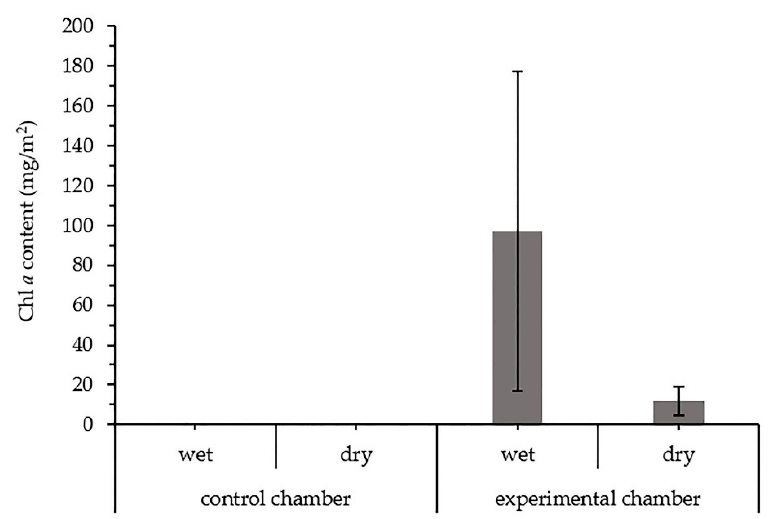
Figure 10. Chlorophyll a content in the biocrusts (mg/m 2 ). The pigment was analyzed in a wet and a dry state of biocrusts. The error bars indicate standard deviation.